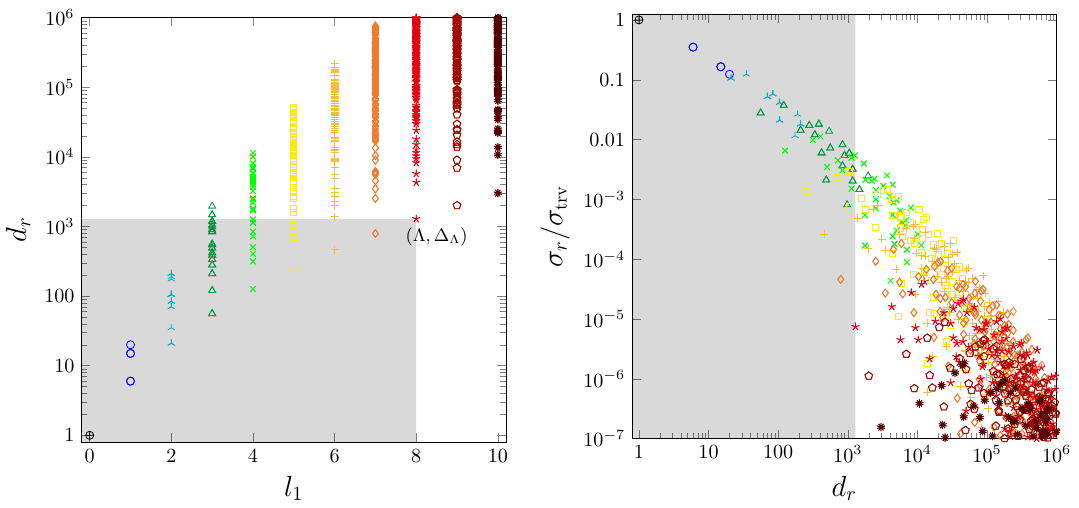
Figure 5 . (Left) The dimensionality of the representations of the SU(6) group is plotted against l 1 . The shaded region corresponds to d r ≤ ∆ Λ and l 1 ≤ Λ with Λ = 8 . (Right) The singular value σ r normalized by σ trv is plotted against the dimensionality for the SU(6) gauge theory with λ = 3 . Different symbols correspond to different l 1 as shown in the left panel. The shaded region corresponds to d r ≤ ∆ Λ with Λ = 8